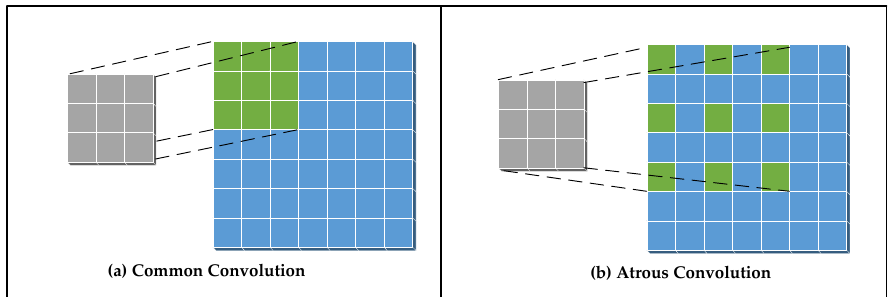
Figure 3. Different convolution operations.